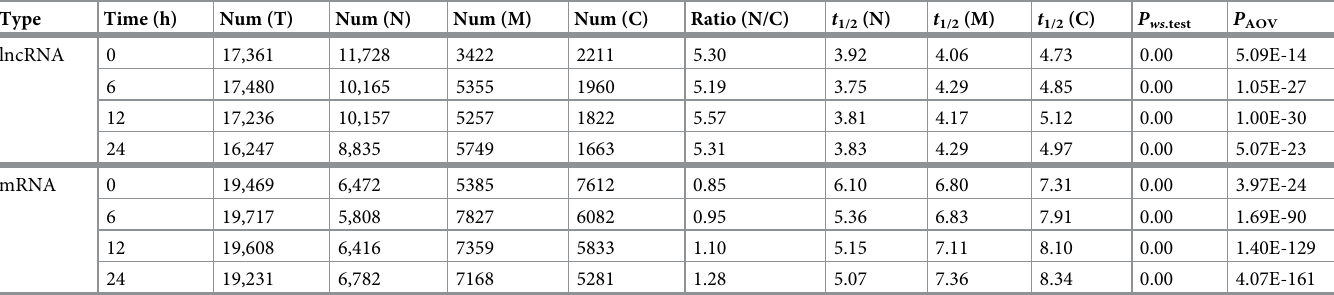
Table 1. Detailed information for both lncRNAs and mRNAs with half-lives enriched in the nucleus and the cytoplasm.